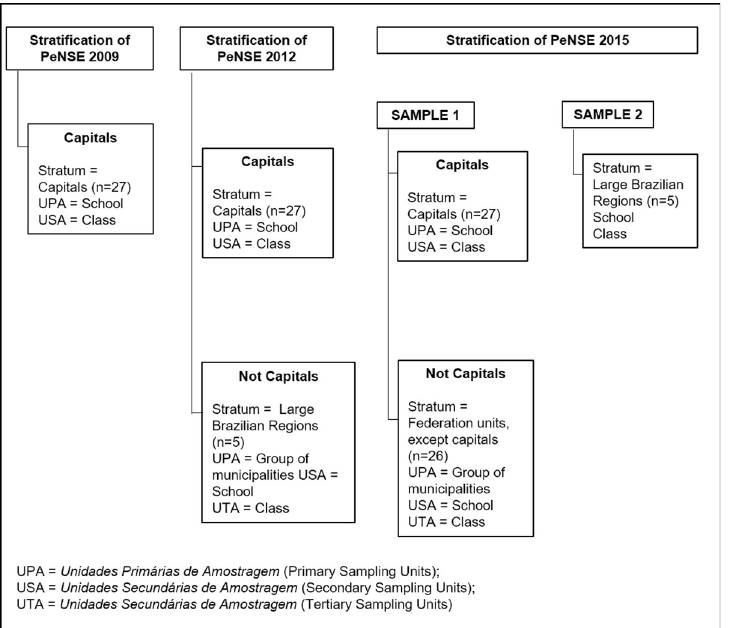
Fig 1. Stratification of